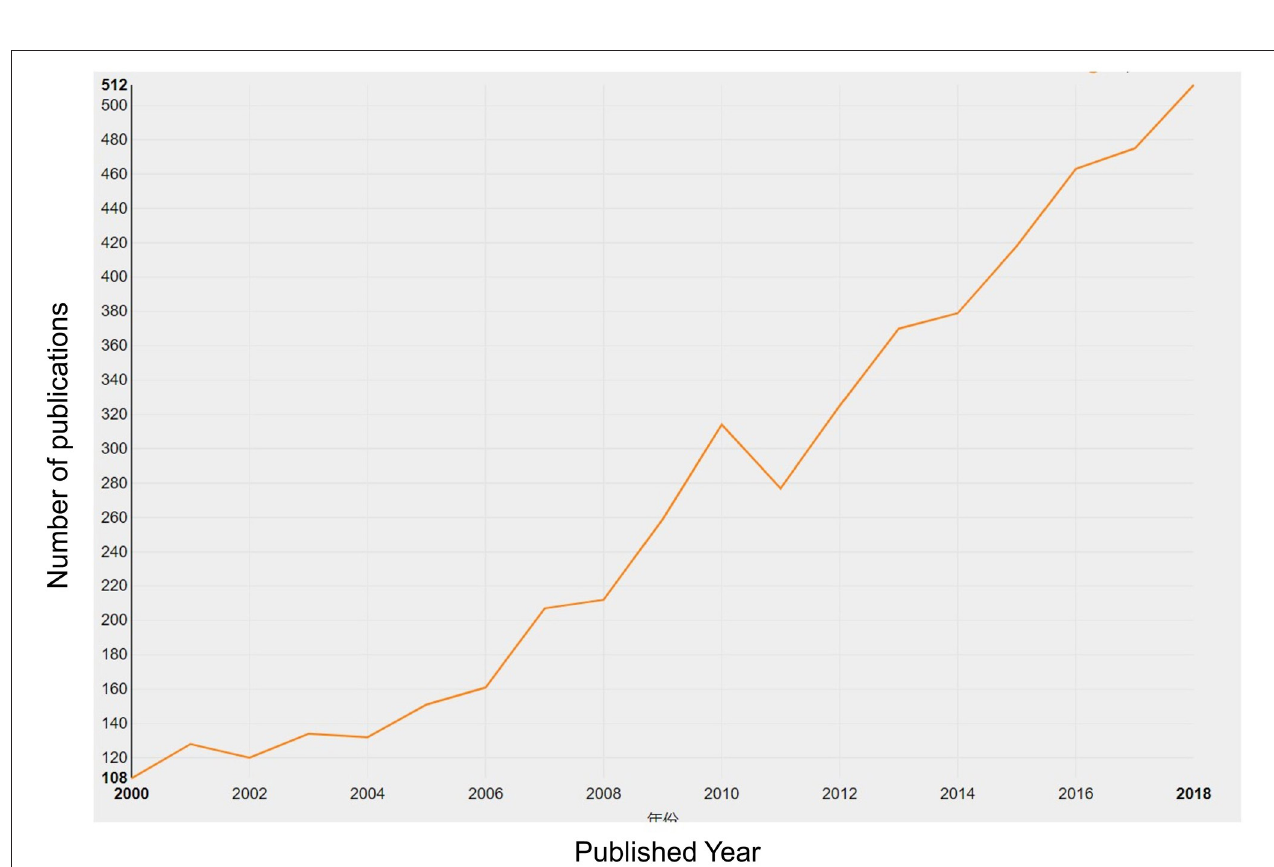
FIGURE 2 | Quantity of relevant literature. The number of annual publications in spinal stenosis from 2000 to 2018.